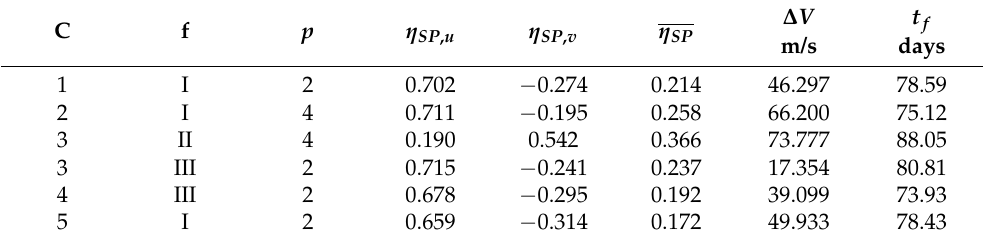
Table 5. EML2 escapes performance—fixed C 3 = 0.2 ( km/s ) 2 , free t f .